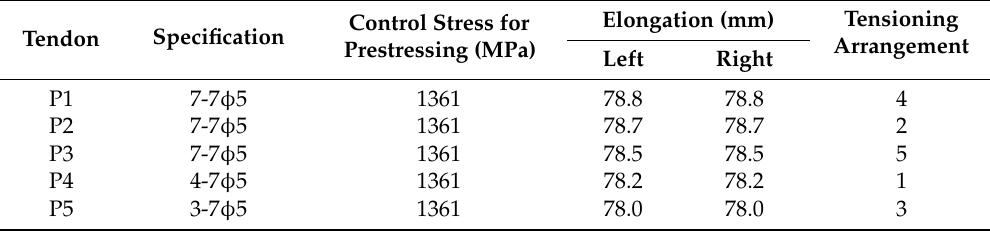
Figure 3. Geometric dimensions of prestressed tendons (unit: mm). Table 1. Mechanical properties of reinforcement steel. Table 2. Details of prestressing the